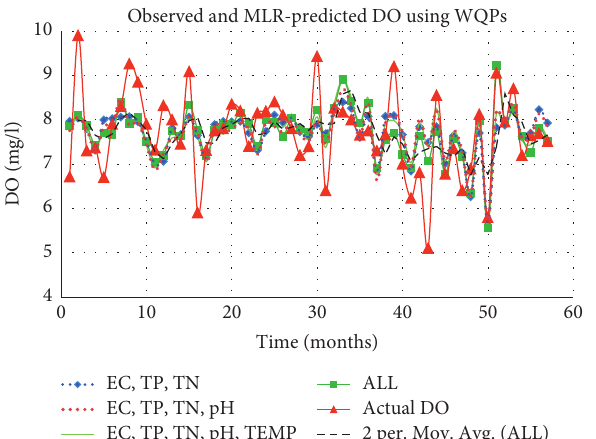
Figure 6: Variations of the observed and MLR-predicted DO concentrations (ALL implies all the water quality parameters as inputs).